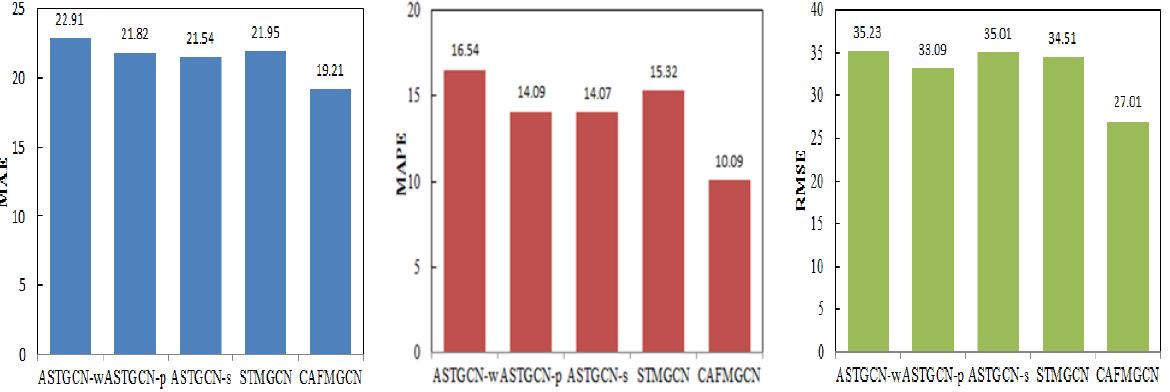
Figure 11. Comparison of average performance of different models of PEMS04.